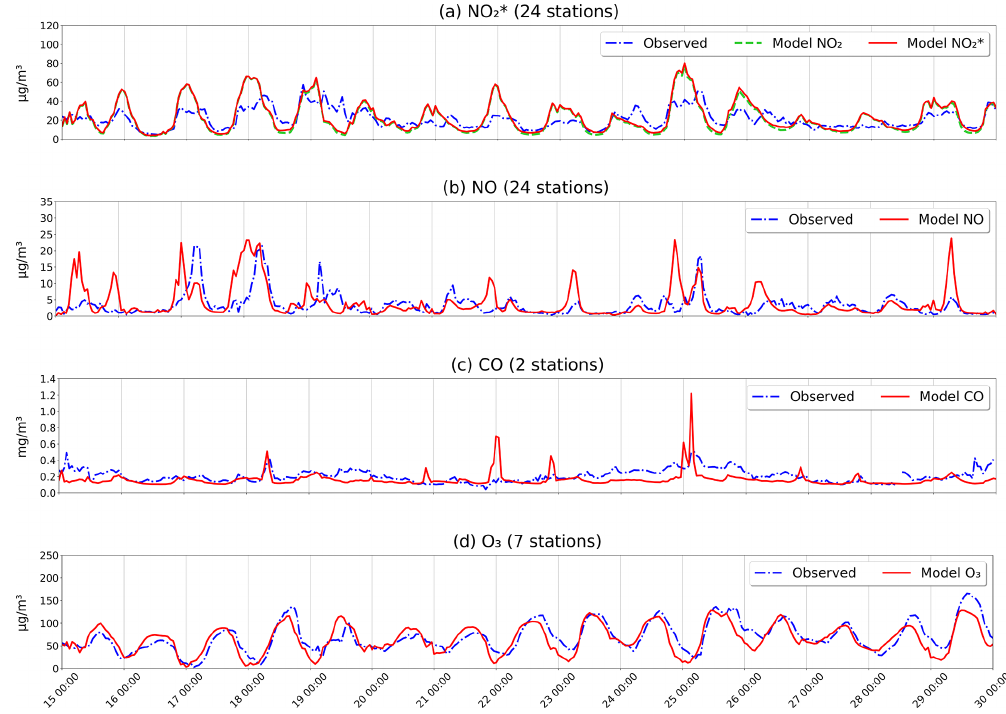
Figure 12. Time series of observed and modeled concentrations of (a) NO ∗ stations for the 15d duration of the reference simulation. Each time series is an average of measurements at the available stations for the corresponding species. Interference-corrected model NO 2 (NO ∗